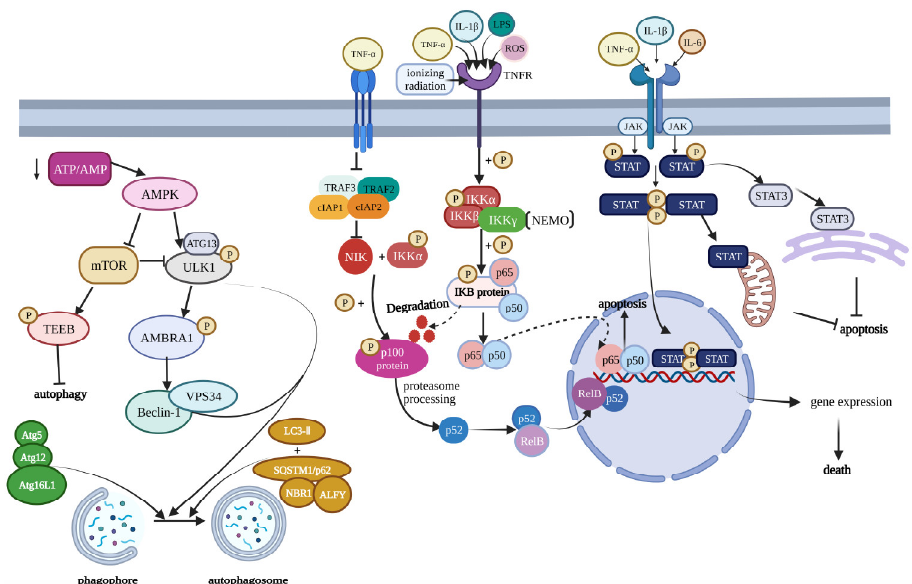
Figure 2. Modulation of cell death pathways in osteoarthritis. This figure contains three main sig- naling pathways, which play an important role in the regulation of OA. From left to right are the mTOR signaling pathway, NF-κB signaling pathway, and JAK/STAT signaling pathway. The mTOR signaling pathway is mainly influenced by the AMPK, and the decrease of ATP/AMP can activate AMPK. The mTOR can produce the phosphorylated TFEB to inhibit autophagy. Furthermore,